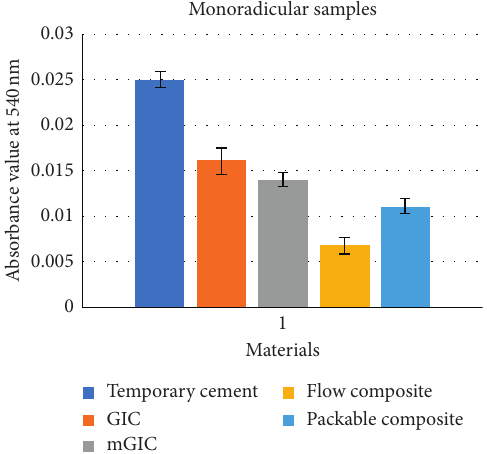
Figure 5: Mean value for all materials for monoradicular samples.